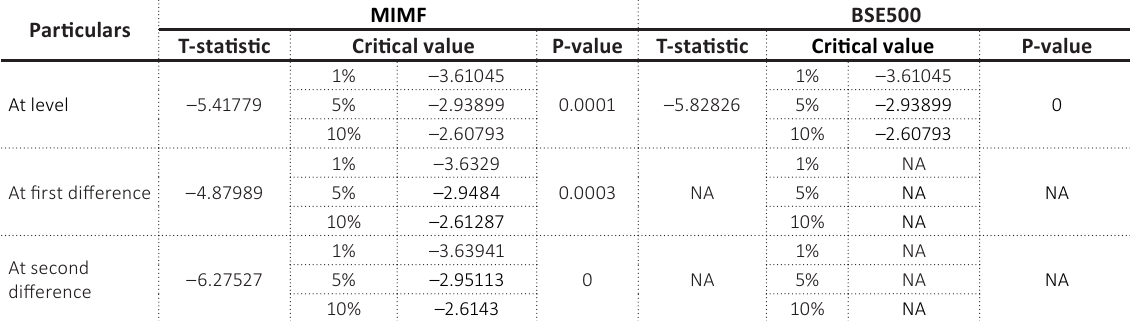
Table 3. ADF test – MIMF and BSE500